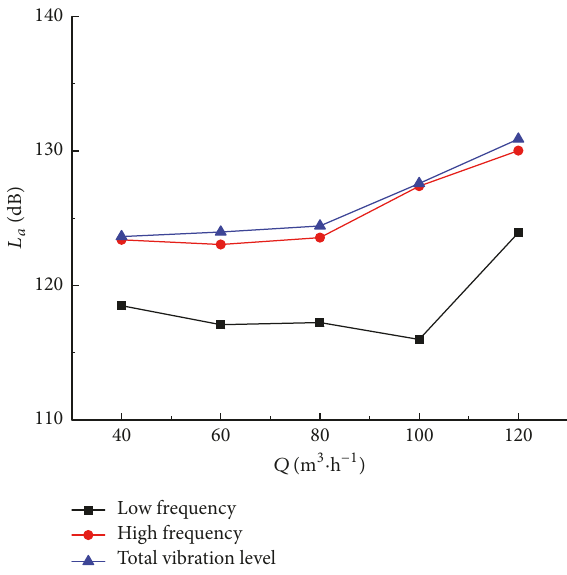
Figure 10: Vibration acceleration in different flow rate. Table 3: Vibration intensity